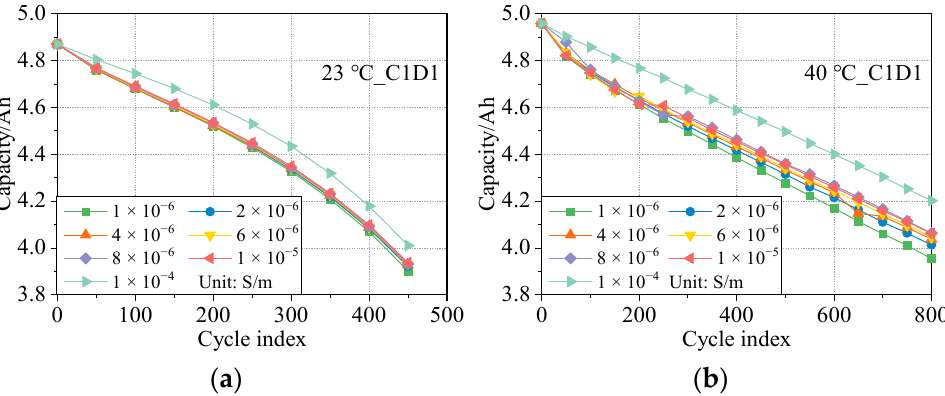
Figure 10. Simulation results of capacity decline when using different SEI ionic conductivities at ( a ) 23 °C and ( b ) 40 °C.